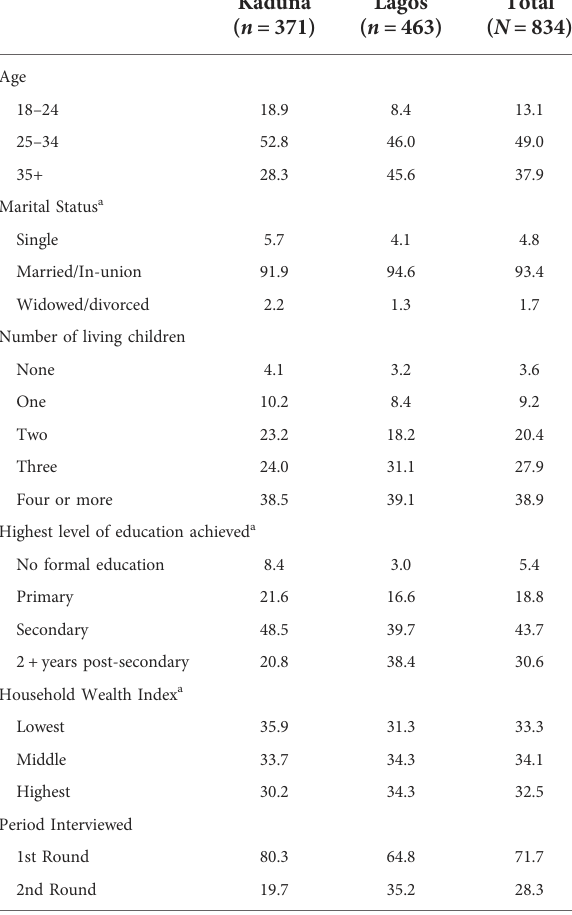
TABLE 1 Respondent characteristics by state, survey. TABLE 2 Demographic characteristics of participants in qualitative